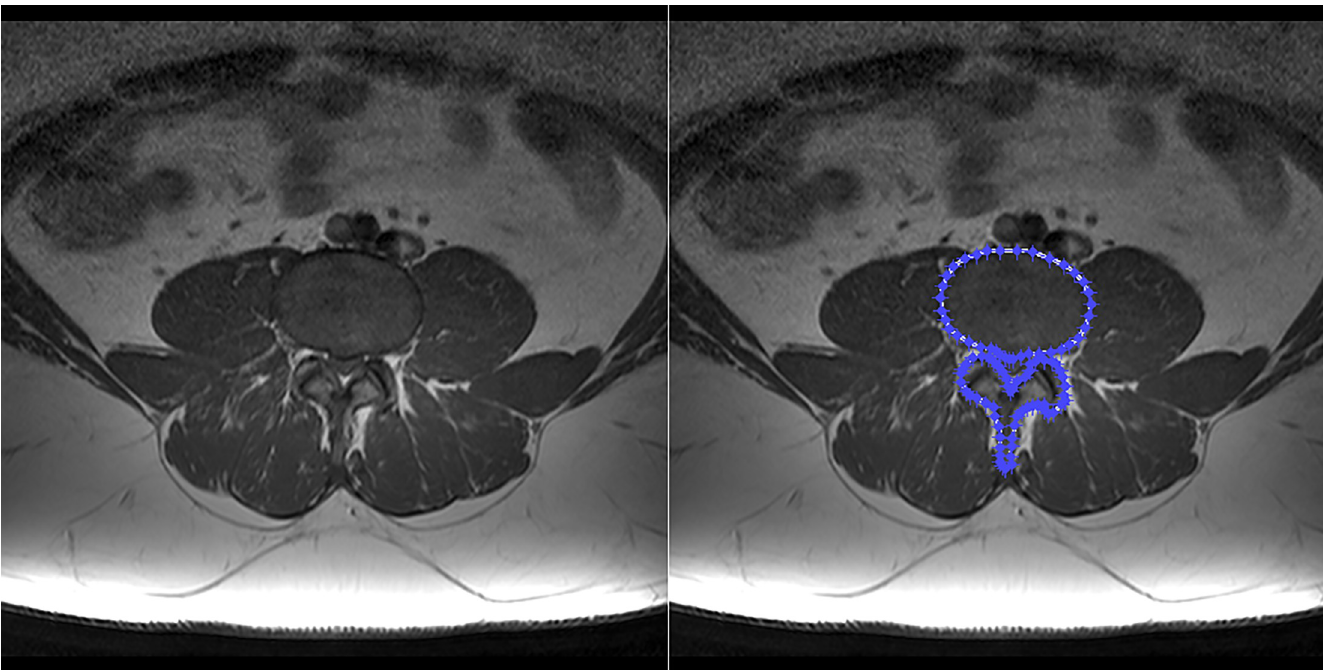
Fig 1. MR image and segmentation. An MR image is shown on the left and the same image is on the right with the vertebral bone outlined.